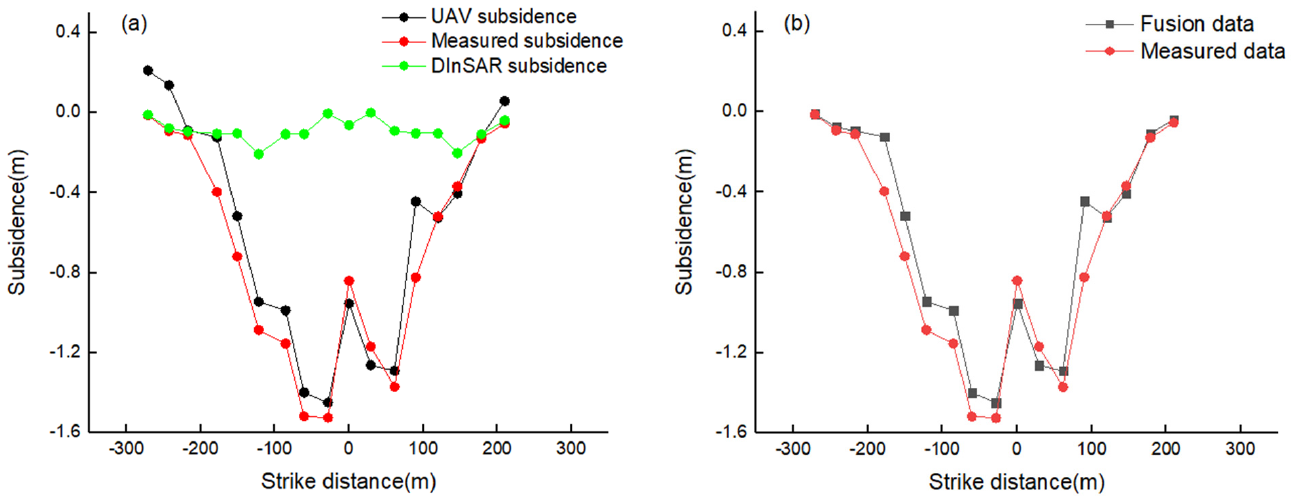
Figure 10. Results before fusion ( a ) and after fusion ( b ) along line C.